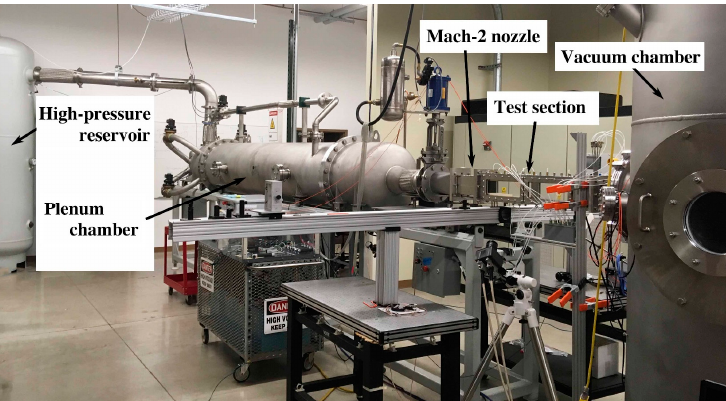
Figure 2. Photograph of the SBR-50 supersonic wind tunnel at the University of Notre Dame.